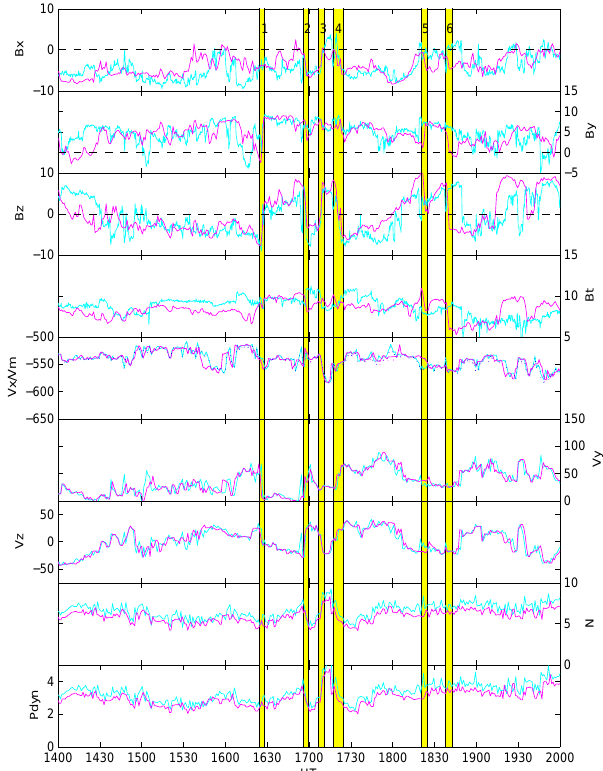
Fig. 1. Wind (magenta) and ACE (blue) data for 14 June 2007, showing in GSE coordinates the solar wind magnetic field param- eters (3 components and total field) and the solar wind velocity (3 components) and density. The data from ACE have been shifted backwards in time by 12min. The yellow shaded areas are the six magnetic field rotations that will be discussed in this